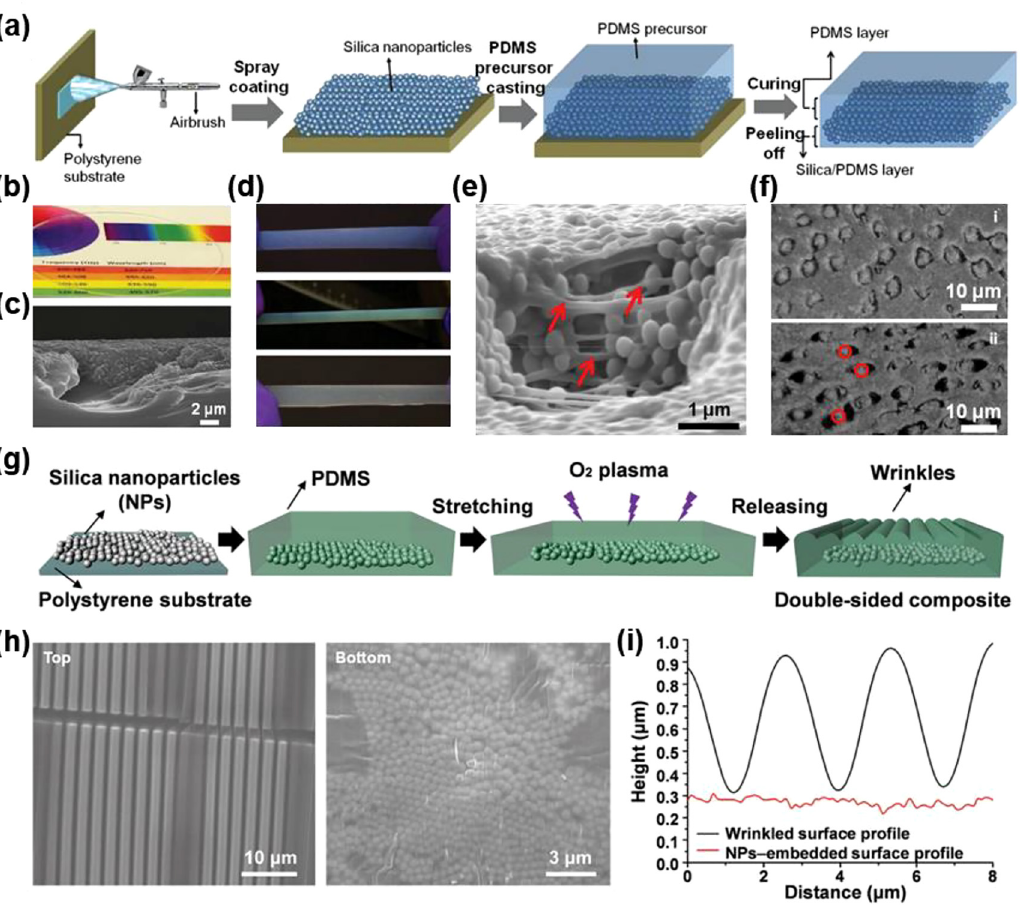
Figure 8: 3D hybrid nanocomposite based on random network of self-assembled nanoparticles for mechanoresponsive scatterer. (a) Schematic illustration of the fabrication process. (b) Digital image and (c) SEM images of the transparent silica/PDMS composite film (unstretched). (d) Digital photographs of stretched films with embedded nanoparticles of various diameters: i) 221, ii) 258, and iii) 306 nm. (e) SEM image of the stretched silica/PDMS fi lm with 258 nm diameter nanoparticles at 80% strain. (f) Optical images of PDMS fi lm